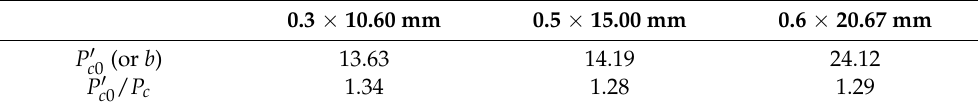
Table 3. Parameters at the initial and terminal positions of